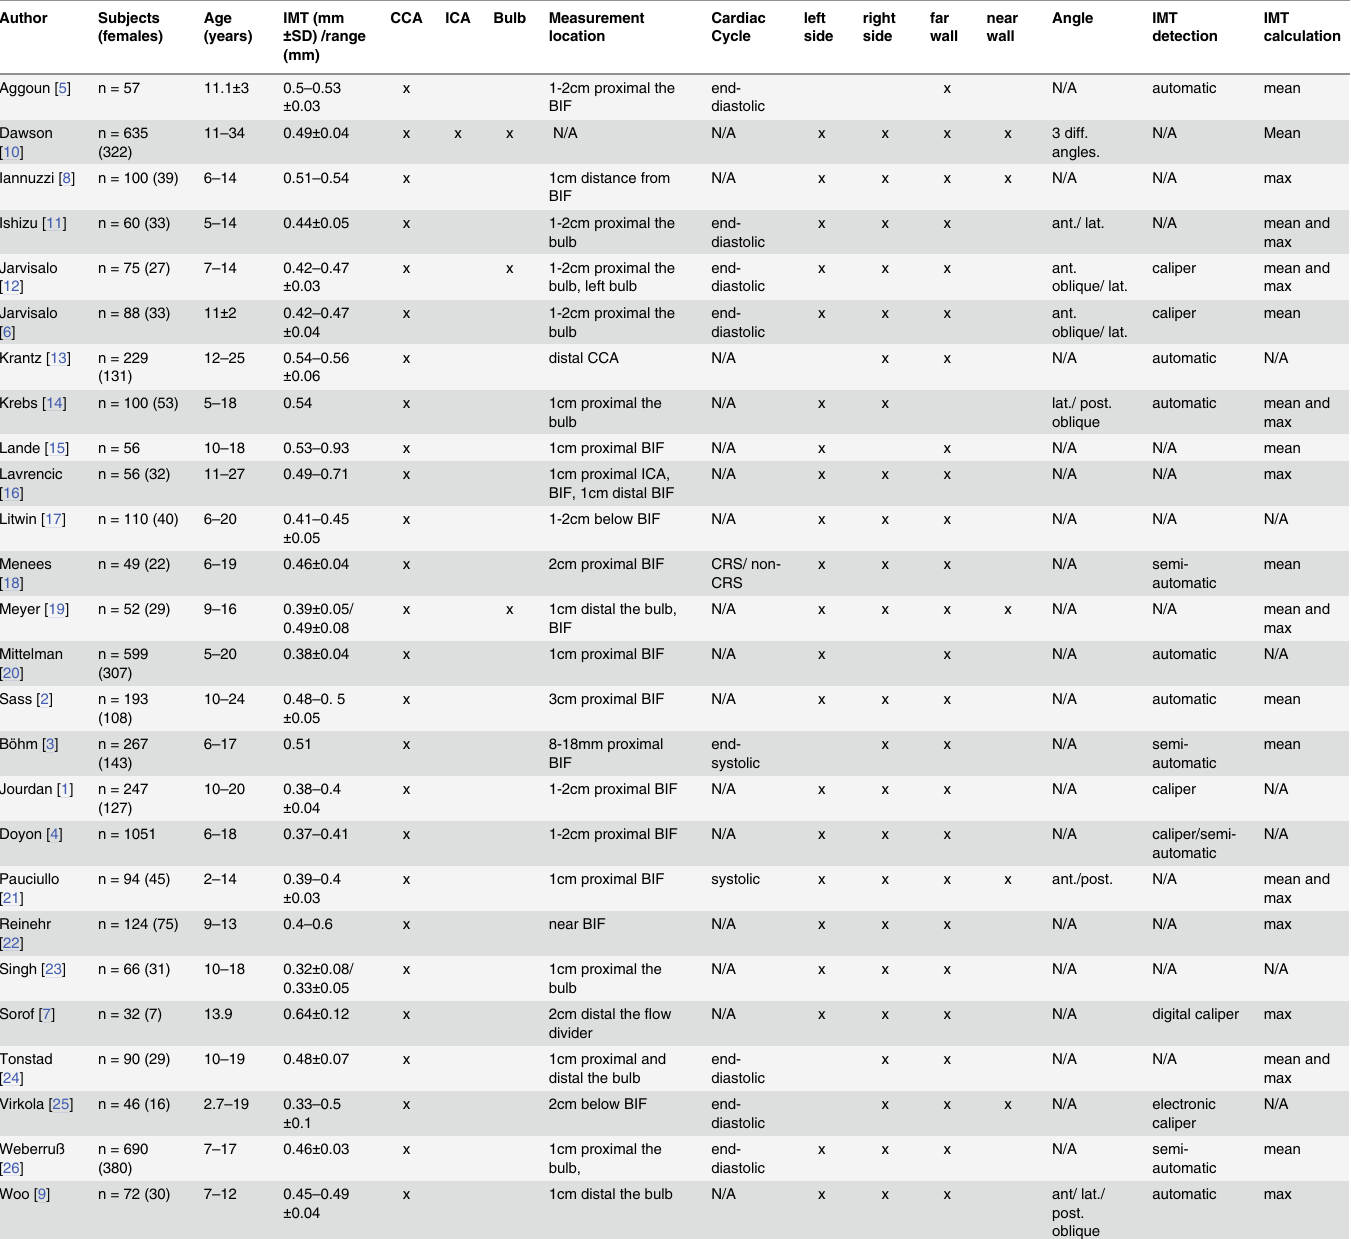
Table 1. Summary of ultrasound B-mode studies measuring intima-media thickness in children and adolescents with different